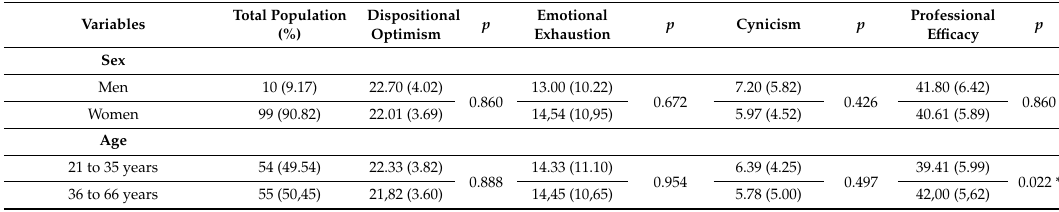
Table 1. Dispositional optimism and burnout scores by sociodemographic, occupational and health variables ( n =